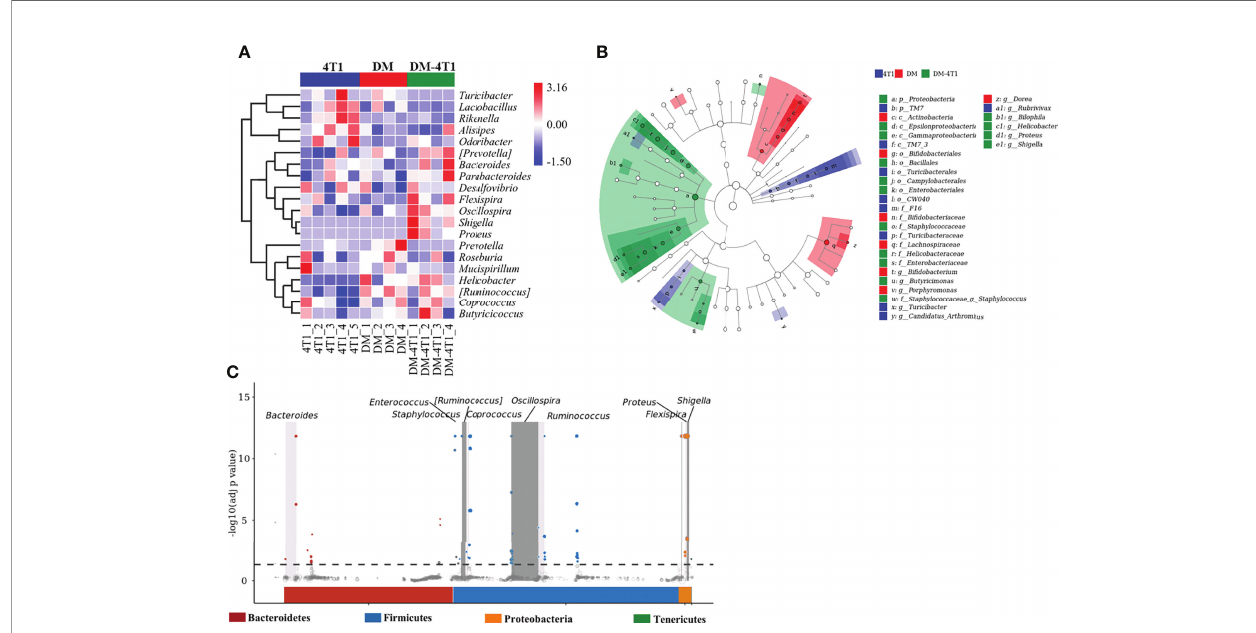
FIGURE 3 | The difference and characteristics of bacteria in different groups. (A) The species composition heat map was created according to the Euclidean distance. (B) LEfSe comparison of gut microbiota between 4T1 and DM-4T1 groups. Taxonomic cladogram derived from LEfSe analysis of 16S sequences. (Red) DM-4T1-enriched taxa; (blue) taxa enriched in 4T1 group. (C) Manhattan plot. The x-axis represents the microbial ASV taxonomy at phylum level, and the y-axis represents -log10 (adj p value). Dots and hollow dots indicate ASVs with and without signi fi cant difference, respectively. The color of each marker represents the different taxonomic af fi liation of the